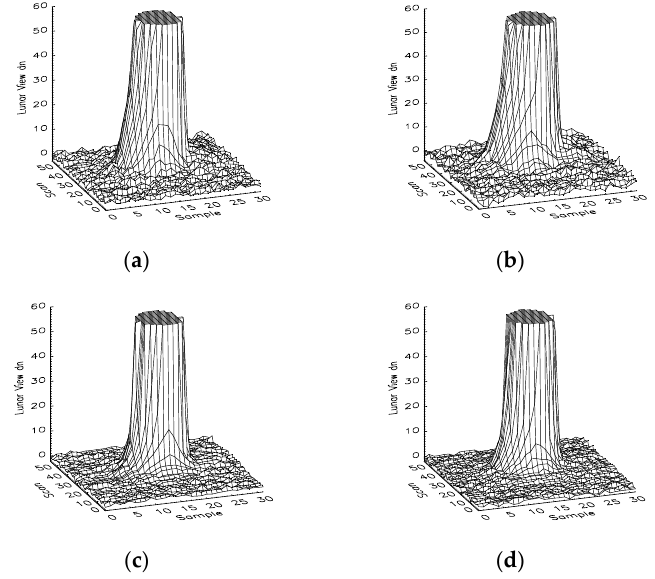
Figure 3. Lunar images observed by SNPP VIIRS thermal emissive Bands M14 and M15 on 2 April 2012: ( a ) Band M14 Detector 8, ( b ) Band M14 Detector 9, ( c ) Band M15 Detector 8, and ( d ) Band M15